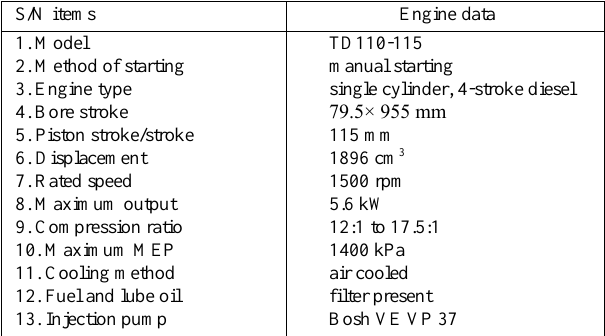
Table 5. Technical specifications of engine [30]